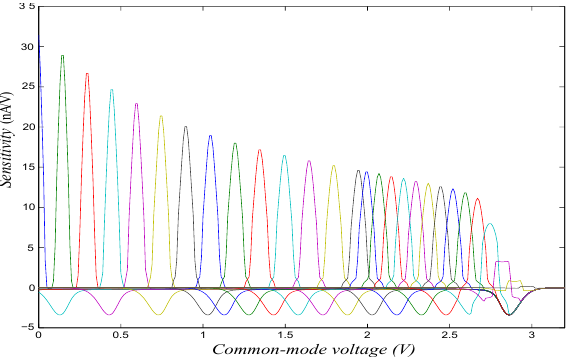
Figure 12. The curves show the sensitivity of the proposed bump circuit when the two inputs have common-mode value increasing from 0 to Vdd . The bias voltage is 2.6 V in this